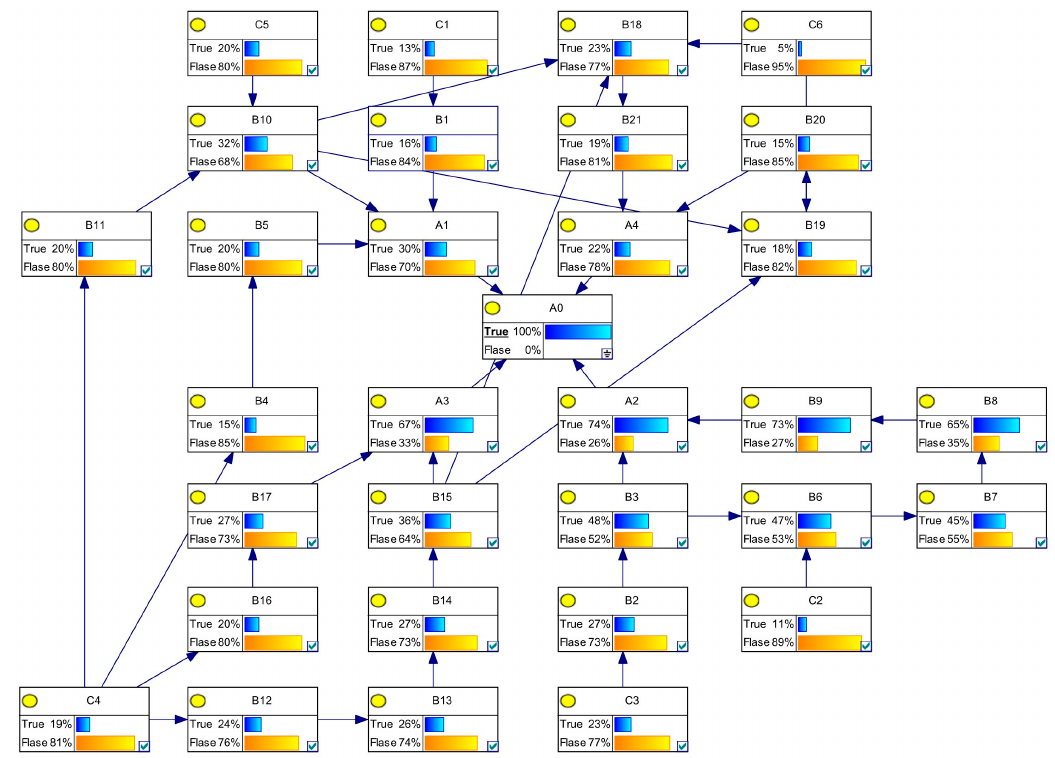
Figure 5. Analysis diagram of catenary construction risks Bayesian network forward inference.